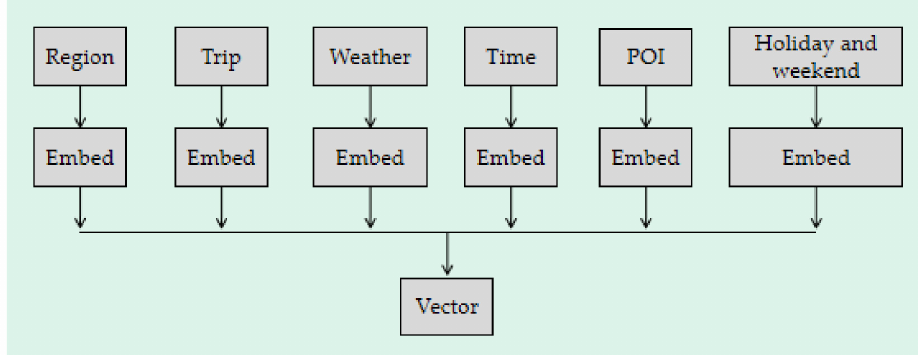
Figure 12. Feature Concatenation.